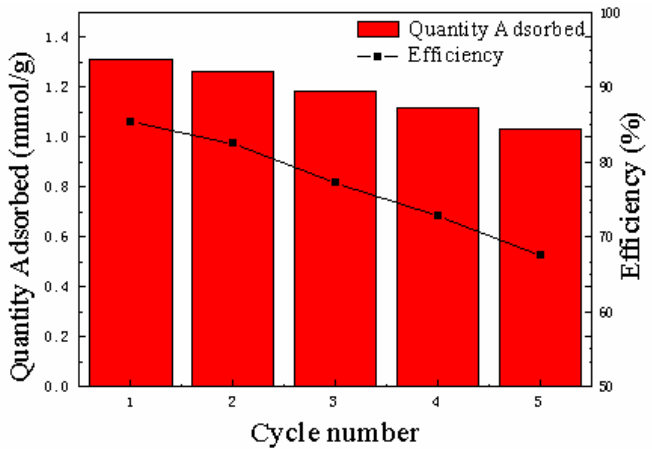
Figure 7. Ethyl acetate adsorption capacities (mmol/g) and efficiency (%) for the use of Dt/S-1 (5 wt%) at different adsorption – desorption cycles (up to